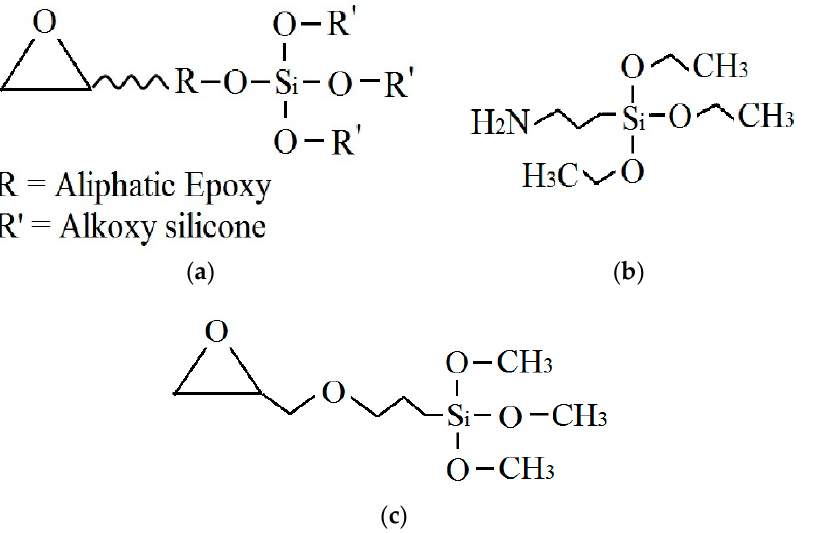
Figure 1. The chemical structure of the main coating components: ( a ) silicone-epoxy resin; ( b ) hard- ener amino-silane; ( c ) 3-glycidoxypropyltrimethoxy silane.